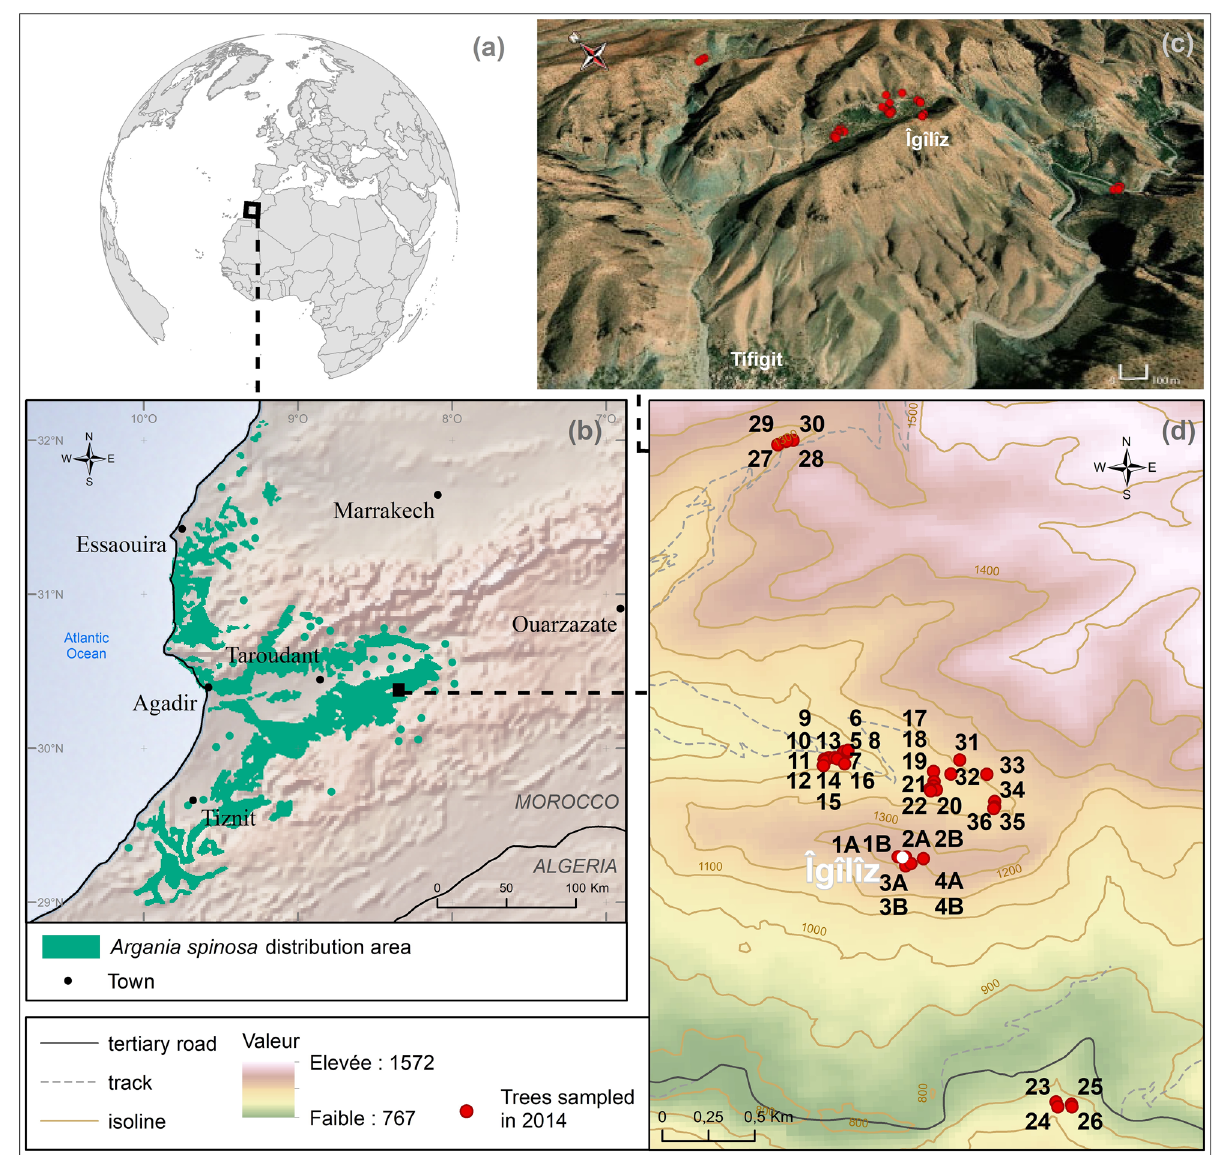
Figure 1. Location of the study area and sampled Argan trees. ( a , b ): Maps and Argan distribution area was drawn with the help of ressources in the public domain, ASTER GDEM (https:// aster web. jpl. nasa. gov/ gdem. asp) and Natural Earth (https:// www. natur alear thdata. com). ( c , d ): Geographical location of the sampled Argan trees is presented using © Esri softwares (ArcMap and ArcGlobe 10.7, Esri World Imagery). Maps were designed and drawn by Laure Paradis (ISEM